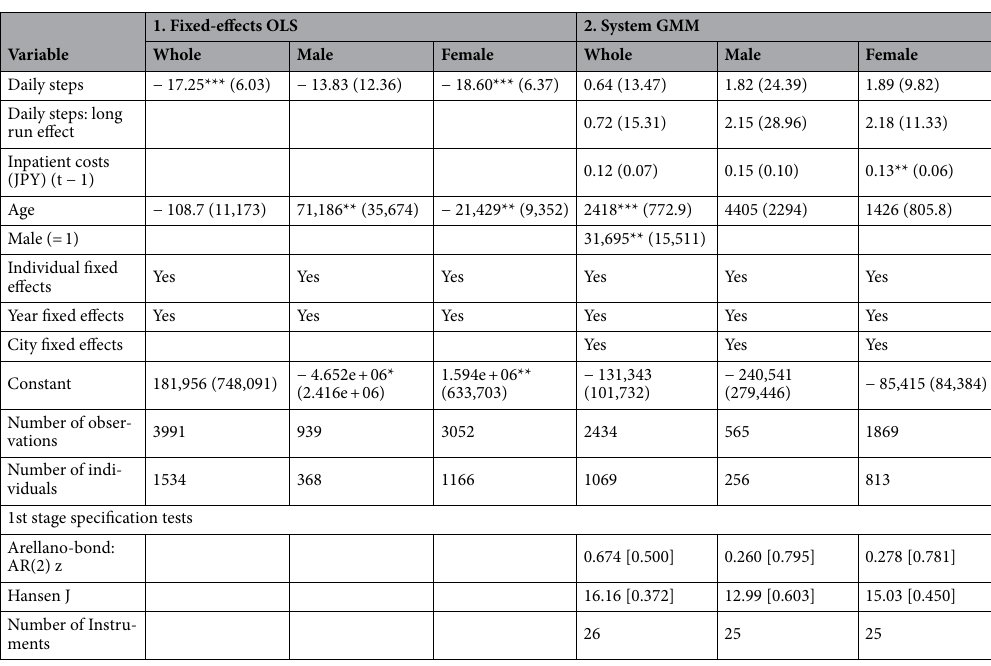
Table 3. Effects of daily step on healthcare costs: inpatient services. Robust standard errors in parentheses. ***p < 0.01, **p < 0.05; p values in brackets. The long-run effects of daily step on healthcare costs are calculated by the coefficient of daily steps divided by 1 minus the lagged coefficient of the dependent variable. OLS ordinary least squares, GMM generalized method of